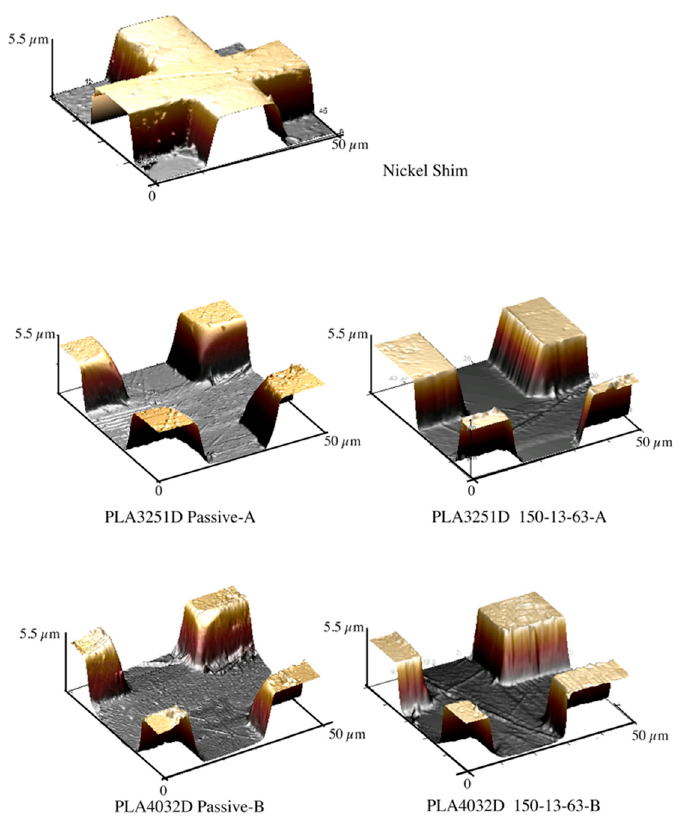
Figure 3. AFM height images of the micro-features on the nickel shim, injection molded samples of PLA3251D and PLA4032D obtained in different conditions of cavity surface temperature.